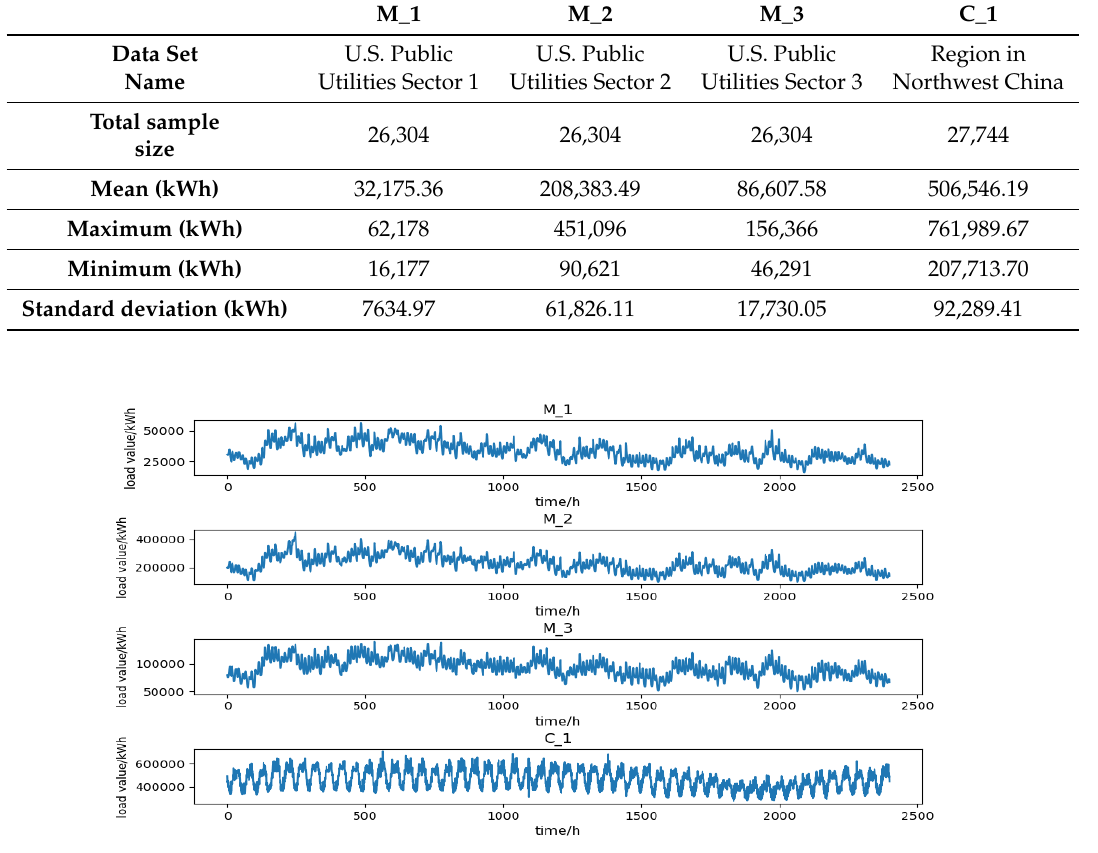
Figure 4. Partial load time series corresponding to four